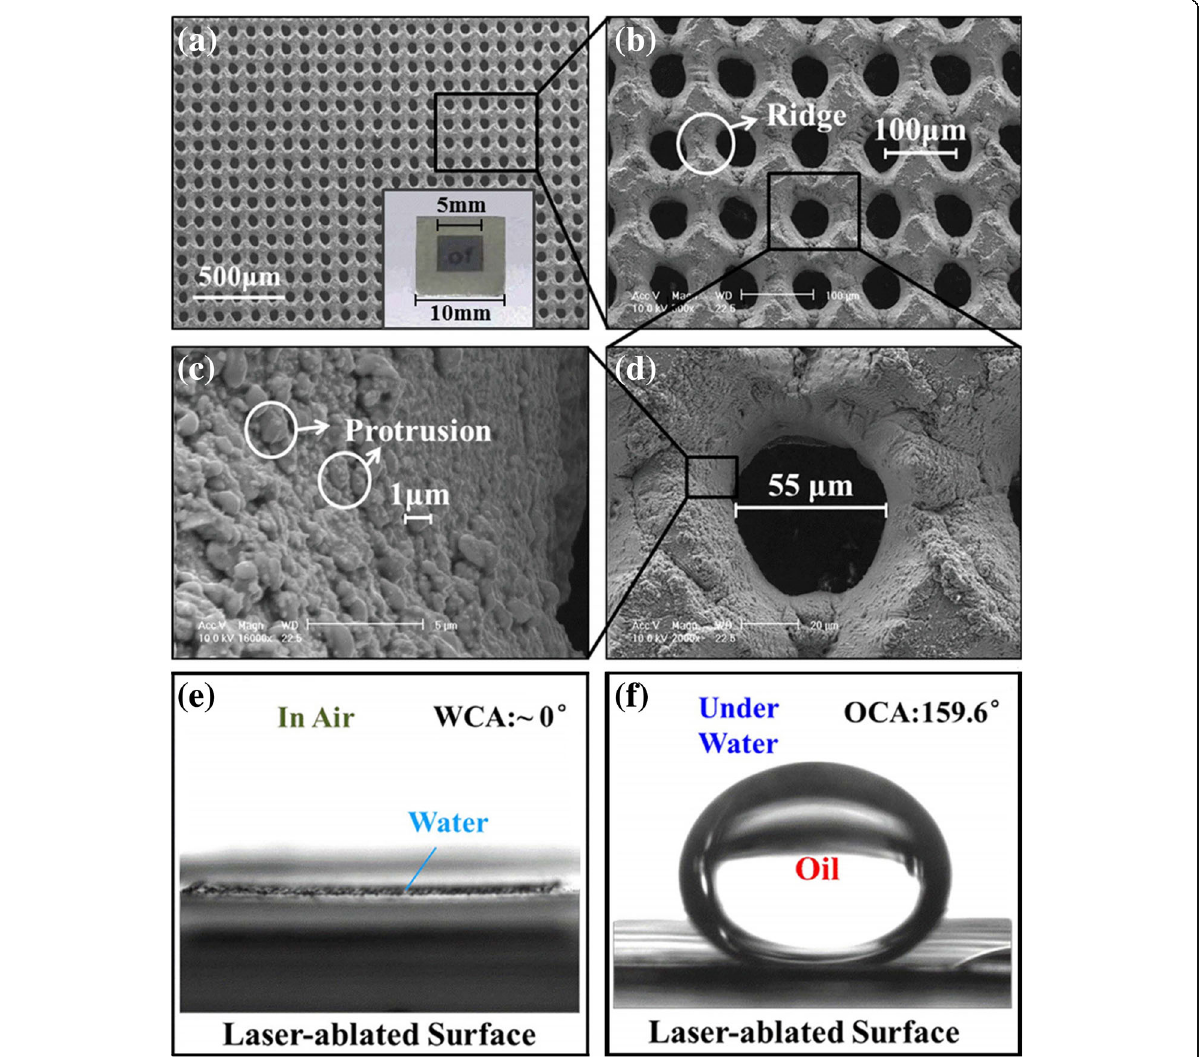
Fig. 8 a – d SEM images of ablated titanium foil fabricated with a laser fluence of 12.4 J/cm2 and a microhole spacing of 100 μ m [8]. e Wetting behaviour of water droplets on the titanium foil surface after laser drilling [8]. f Wetting behaviour of underwater oil droplets on the titanium foil surface after laser drilling